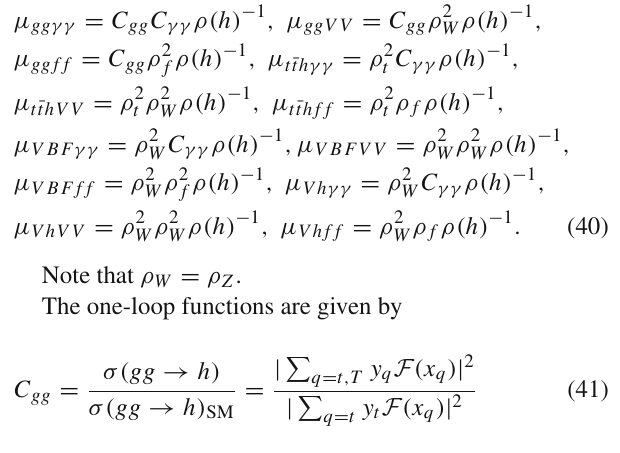
constraints of the a μ from the experiemnts. All the samples are allowed h by the constraints of muon g − 2, which is given in Eq. , with the R